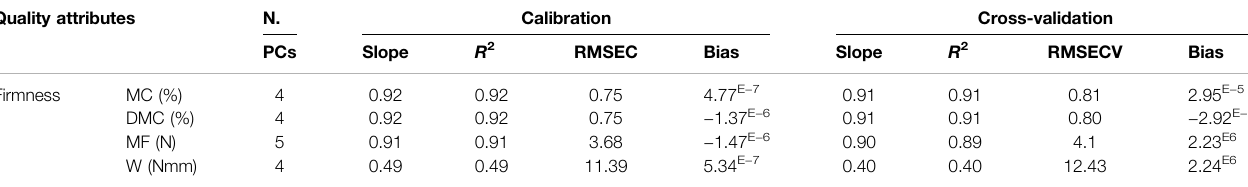
TABLE 2 | Calibration and cross-validation models for predicting MC, DMC, and fi rmness in date samples. Quality attributes N. Calibration Cross-validation PCs Slope R 2 RMSEC Bias Slope R 2 RMSECV Bias Firmness MC (%)